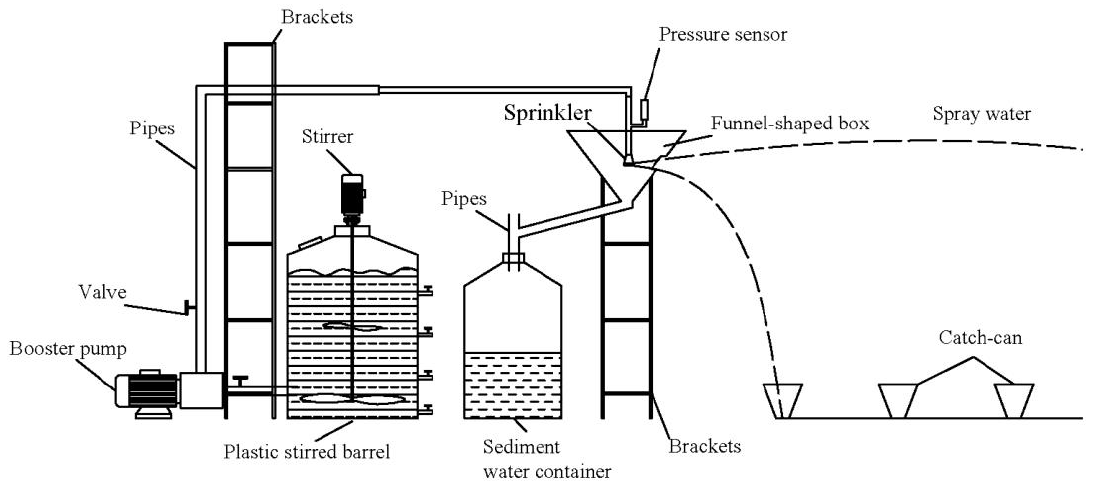
Figure 1. Experimental setup for sprinkler sediment-water distribution.